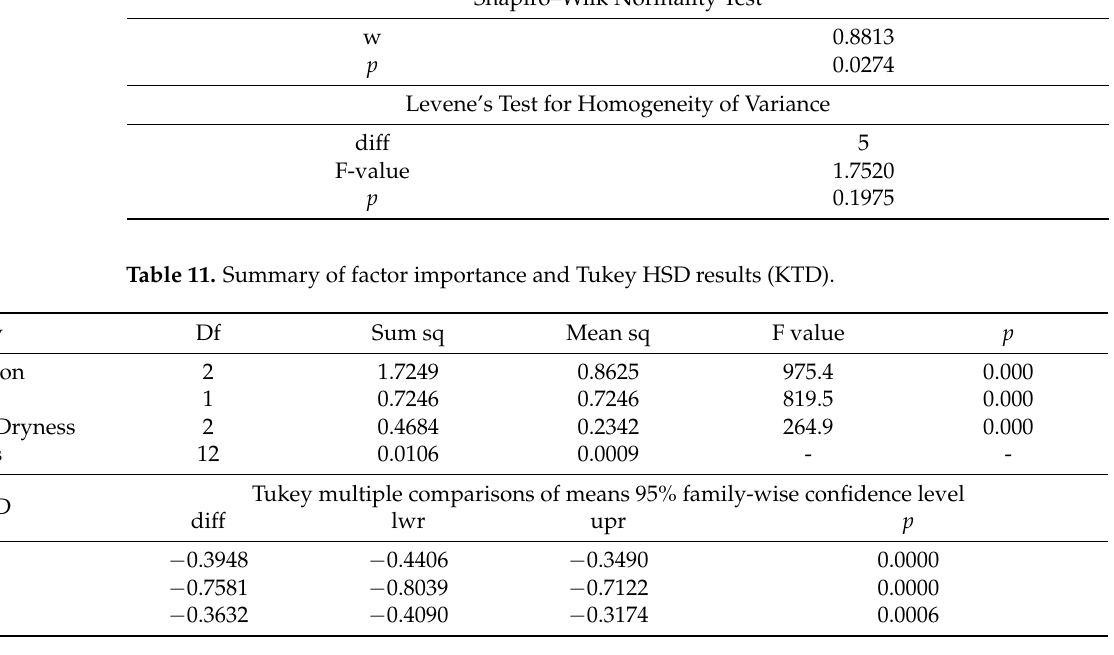
Table 12. Shapiro and Levene’s test result (KL).